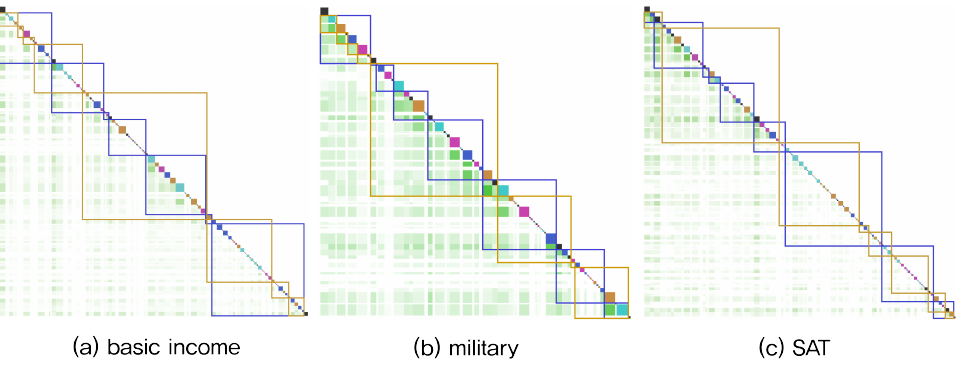
Figure 28. Topic segments of